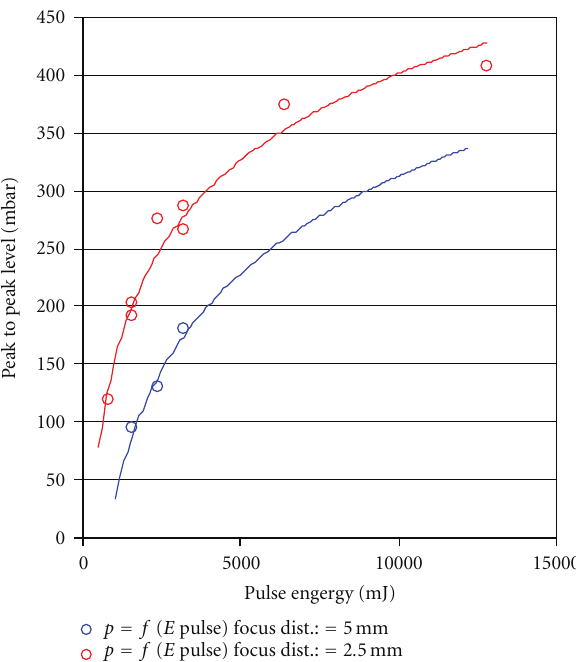
Figure 9: Peak pressure in relation to pulse energy using the CO 2 - Laser at varying focal distance from the measuring